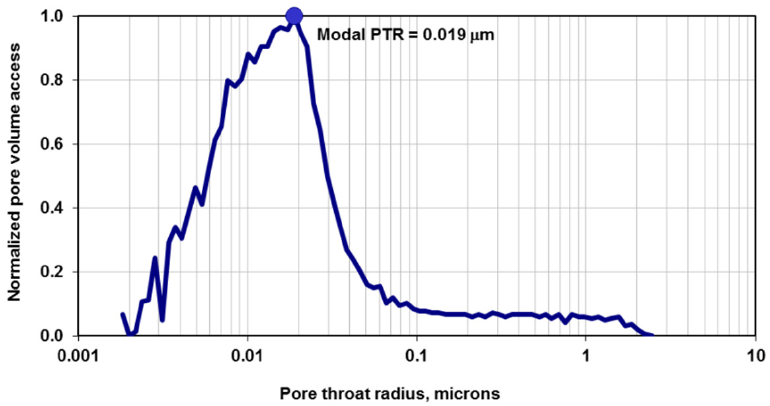
Figure 1. Typical measured pore throat radius (PTR) of Bakken shale rock from high-pressure mercury-air capillary pressure experiments [3]. This plot indicates that the majority of the pores have PTR of 19 nm, but the sample is heterogenous in terms of pore size (ranging from 2 nm to 2 microns).